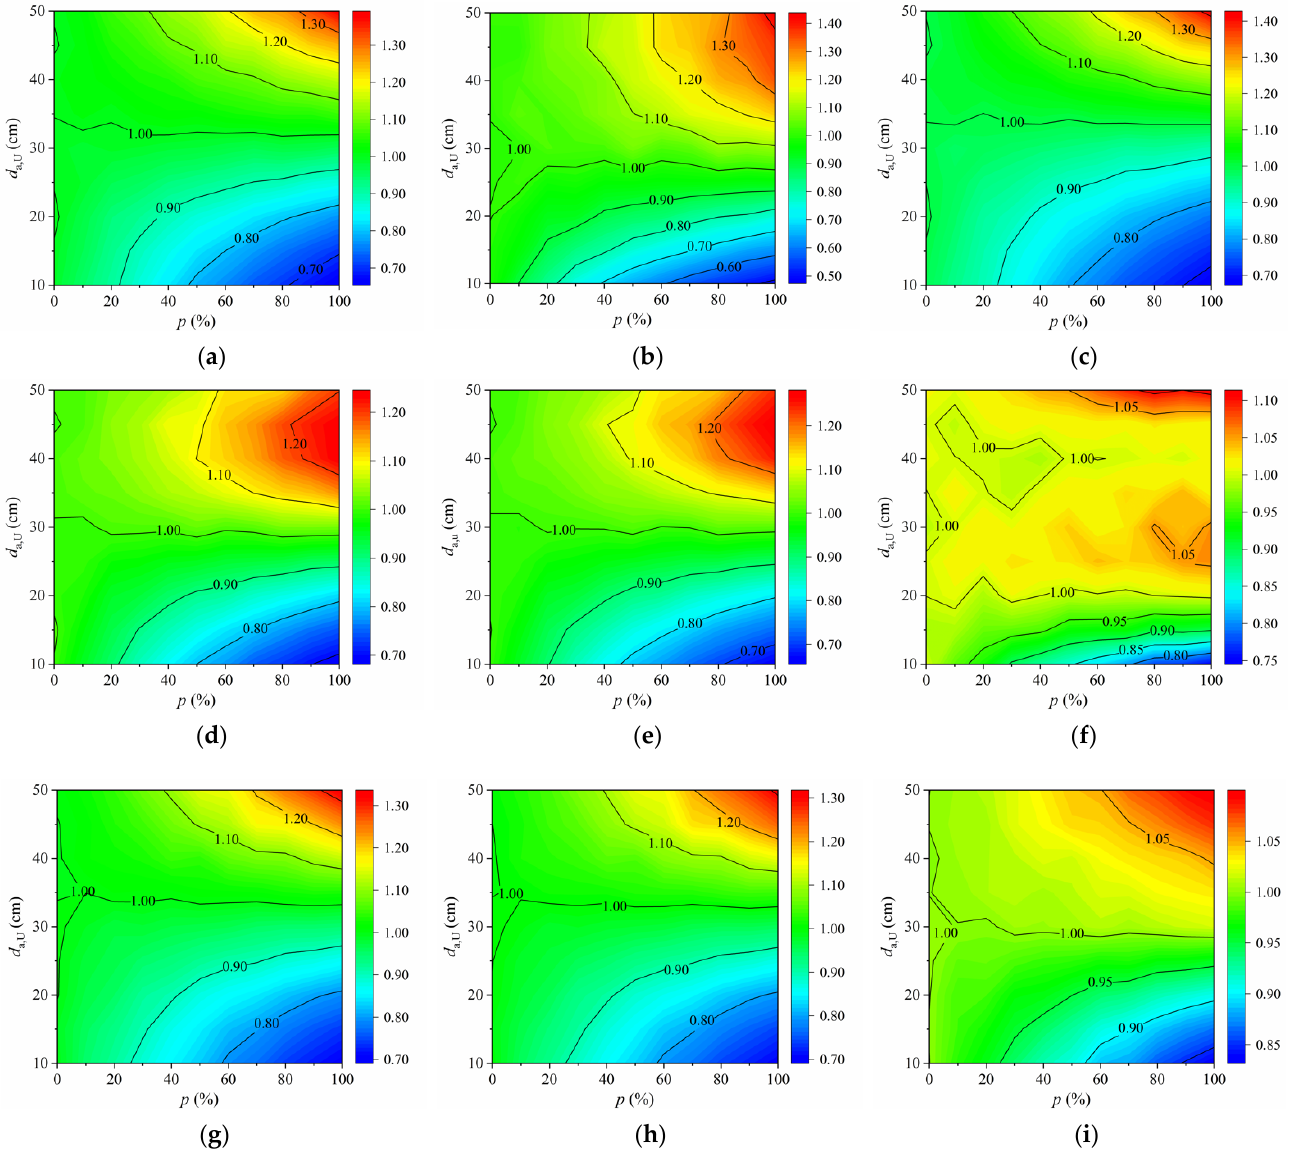
Figure 12. Y m / Y h of fatigue details under the scenario of Pattern 1: ( a ) D1 in COSD; ( b ) D2 in